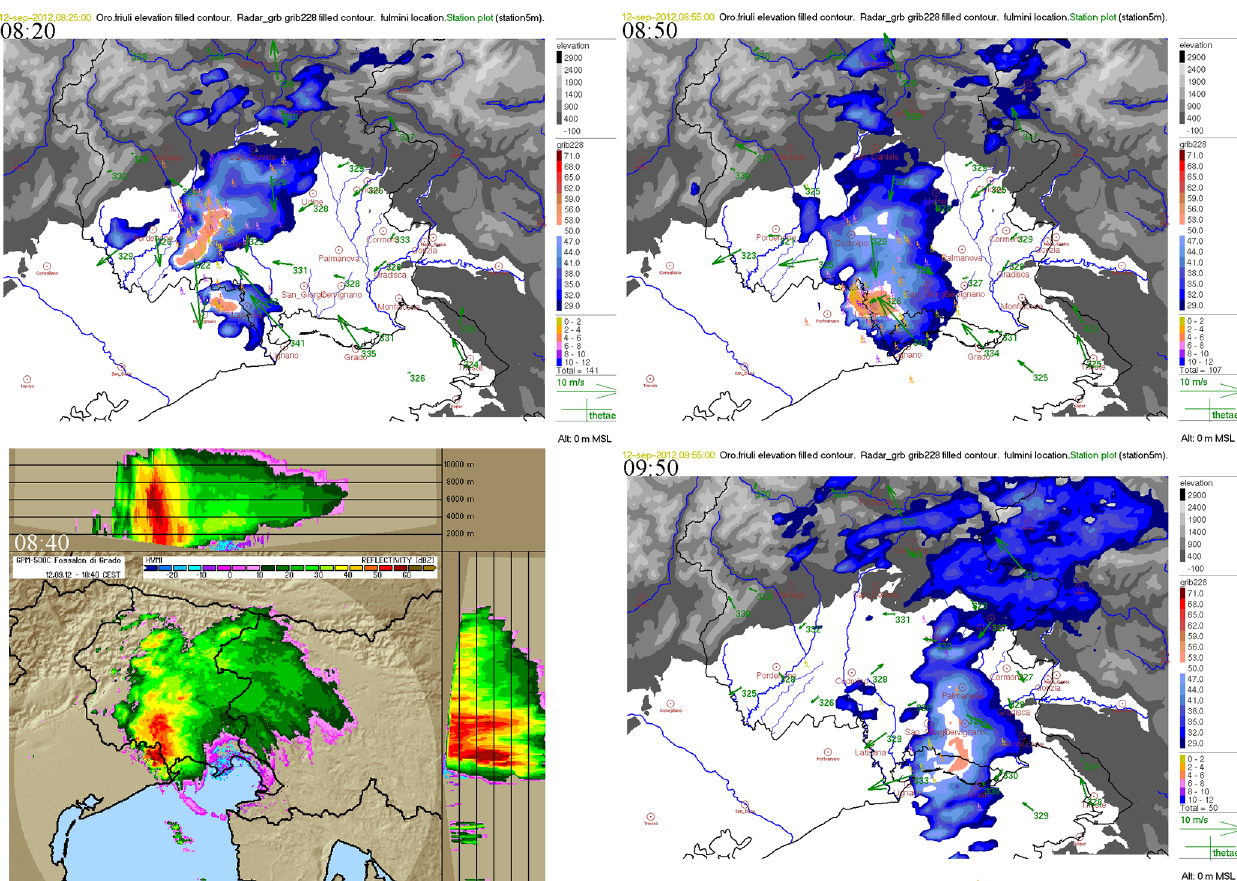
Figure 5. Vertical maximum intensity (VMI) of the reflectivity measured by the Fossalon di Grado radar, with θ e (red–blue color bar in dBZ) and 10m wind observed by surface stations (5min time resolution) and CESI-Sirf cloud-to-ground lightnings within the ± 6min interval (lower color bar shows time delay in minutes) at 08:20, 08:50, and 09:50UTC, 12 September 2012; bottom left: Fossalon radar maximum re- flectivity at 08:40UTC VMI and lateral projections (horizontal vertical maximum intensity – HVMI) (reprinted from Atmospheric Research , 153, Manzato et al., 2015. 12 September 2012: A supercell outbreak in NE Italy?, 98–118, © Elsevier 2015, with